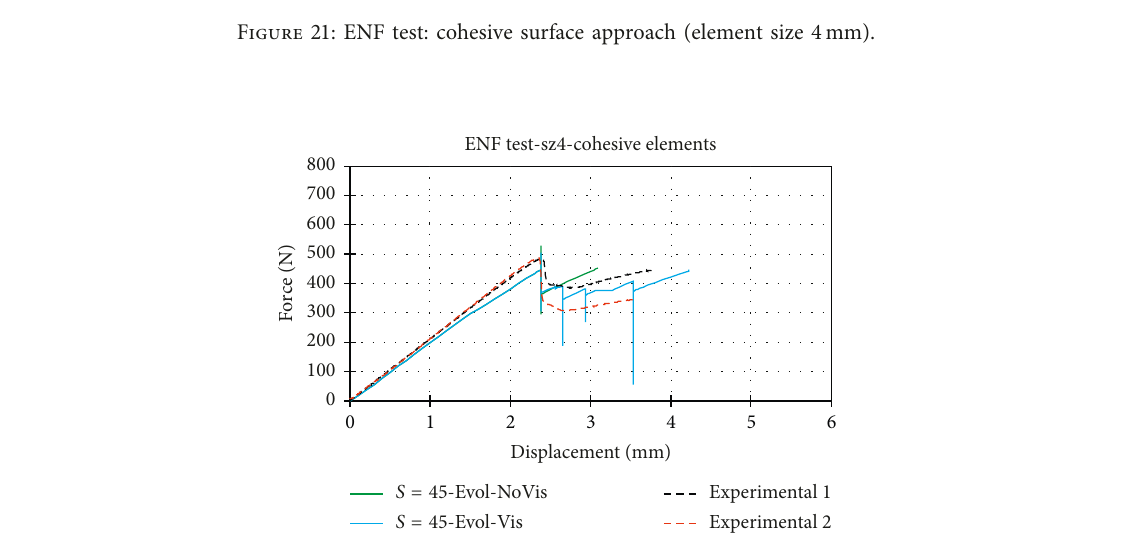
Figure 22: ENF test: cohesive element approach (element size 4mm).